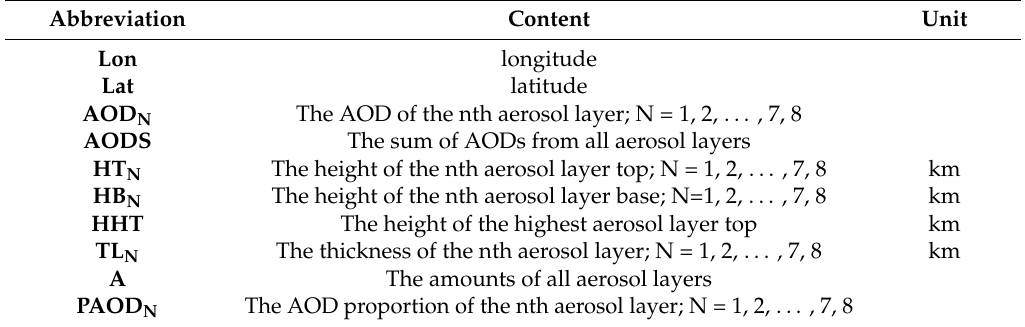
Figure 1. The geographical locations of the TP. Table 1. Description of used parameters in this study.